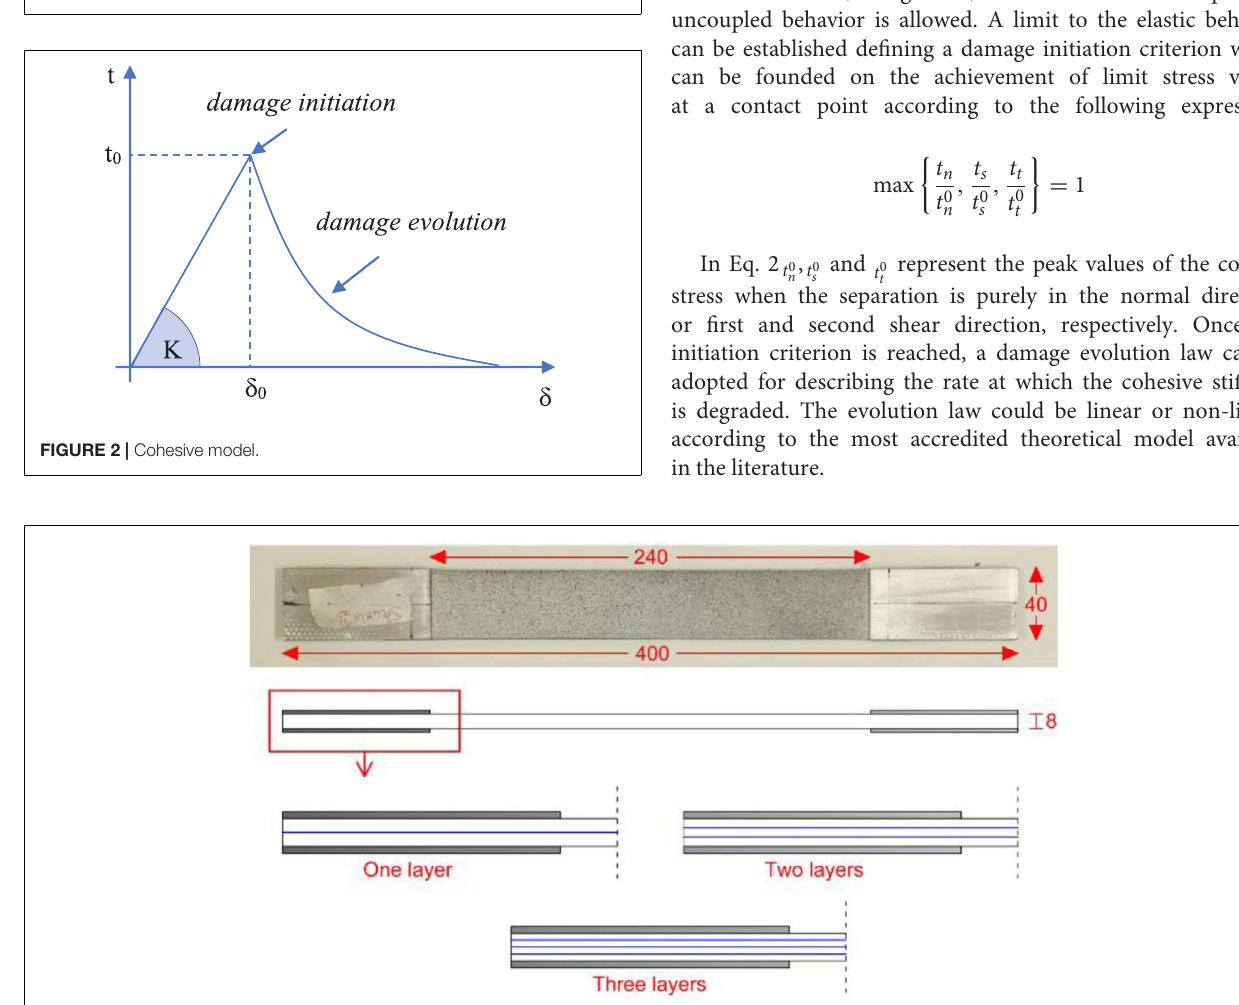
Frontiers in Built Environment |